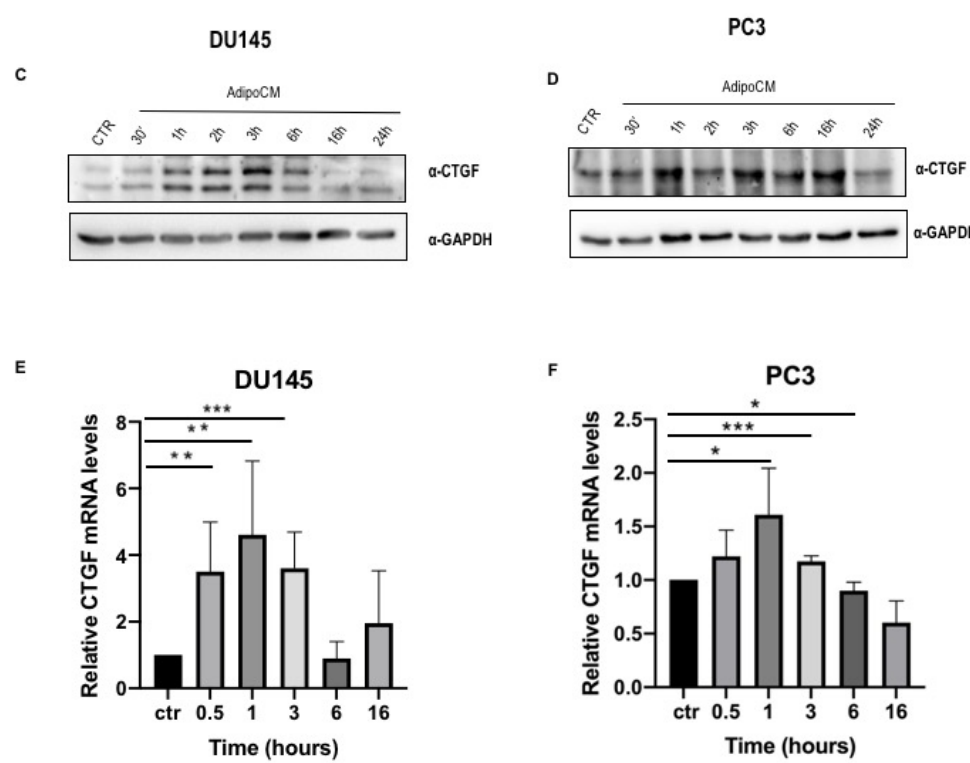
Figure 3. CTGF protein expression was upregulated by PPAT AdipoCM incubation. ( A , B ) DU145 and PC3 cells were seeded (2 × 10 5 cells/well) in 12-well plates and incubated with serum-free media or AdipoCM from five different PCa patients. Cells were solubilized, and protein samples analyzed by Western blot with CTGF antibody. GAPDH antibody was used for normalization. Blot results were revealed by ECL and the autoradiograph is representative of three independent experiments. ( C , D ) DU145 and PC3 cells were incubated with PPAT AdipoCM at different time points, as indicated. Protein expression of CTGF was analyzed by Western blot using GAPDH antibody for normalization. ( E , F ) mRNA abundance of CTGF was measured by real-time RT–PCR analysis of total RNA using PPIA as internal standard with CTGF antibody. GAPDH antibody was used for normalization. * Indicates a p -value < 0.05, ** indicates a p -value < 0.01 and *** indicates a p -value <